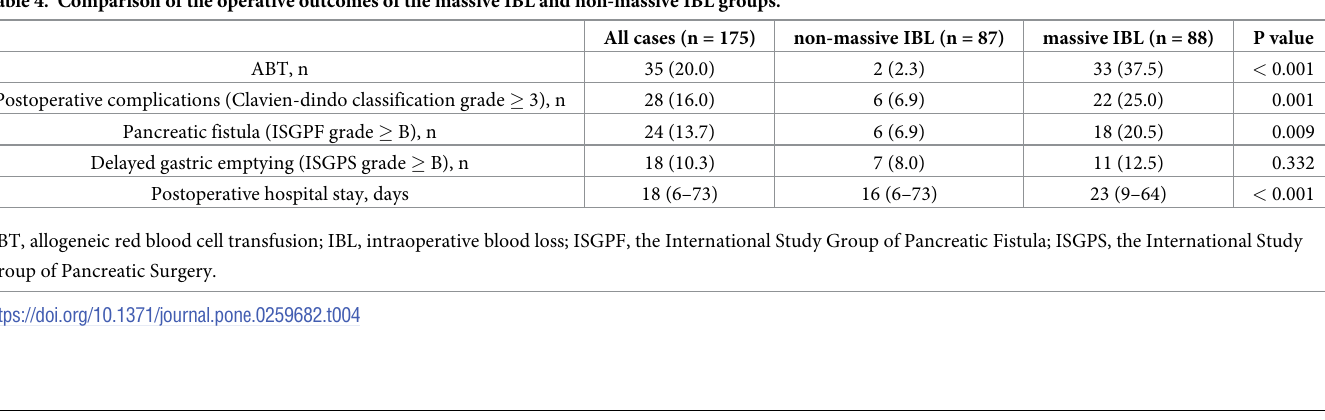
All cases (n = 175) non-massive IBL (n = 87)